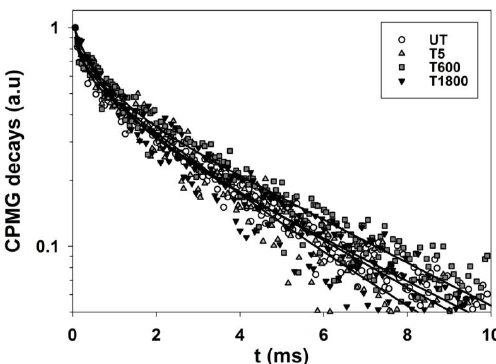
Figure 7. Carr Purcell Meiboom Gill CPMG magnetization decays measured at a depth of 5 mm on water-saturated sandstone specimens. Adapted from [50]. Copyright Spriger Nature, 2011. Table 4. T 2 relaxation times and relative populations measured in sandstone specimens. The error on the parameters is less than 10% of the nominal value.